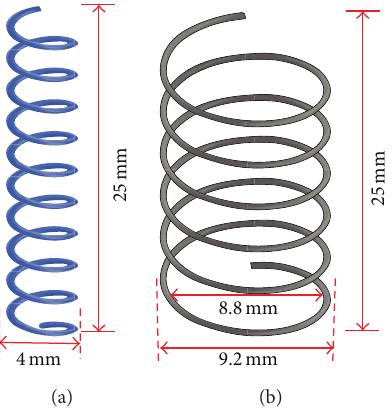
Figure 5: (a) Dimension of SMA spring; (b) bias spring design.